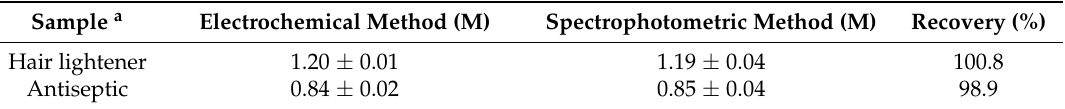
Table 3. Hydrogen peroxide found in the commercial samples measured by both the electrochemical and xylenol orange methods.